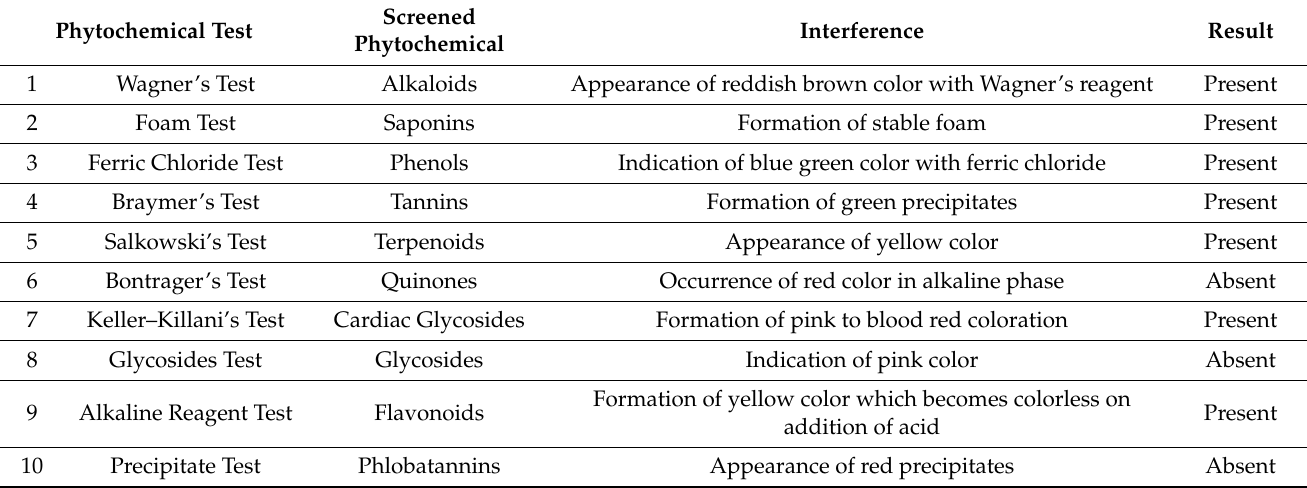
Table 2. Phytochemically screened compounds present in the seed tincture of Nigella sativa